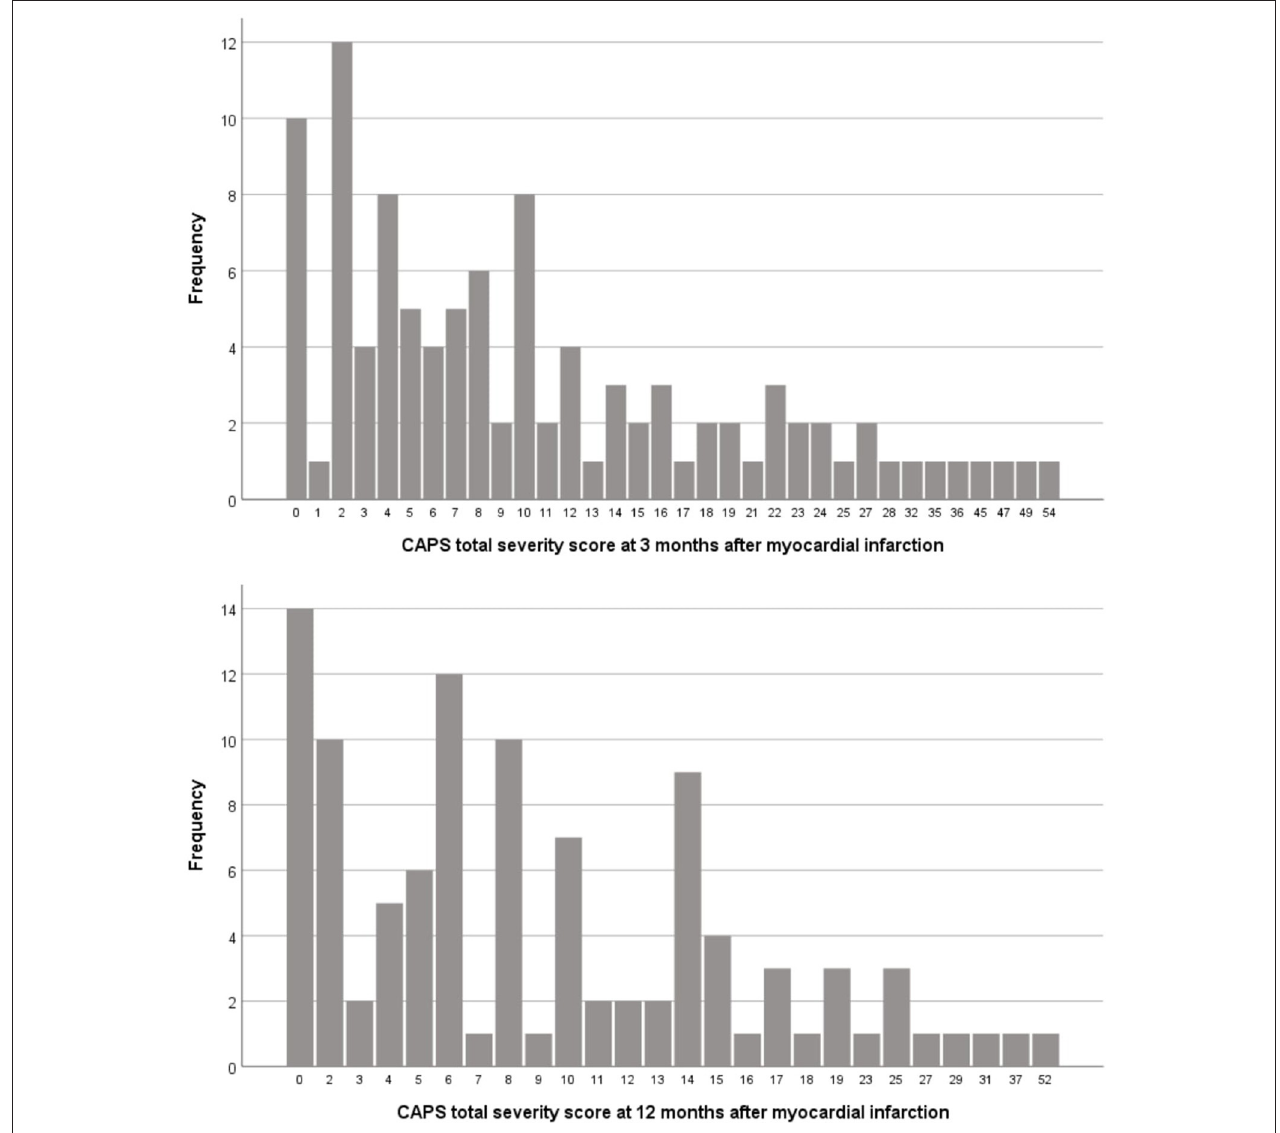
FIGURE 2 | Distribution of CAPS total severity scores at the two follow-up assessments. CAPS, Clinician-Administered Post-traumatic Stress Disorder